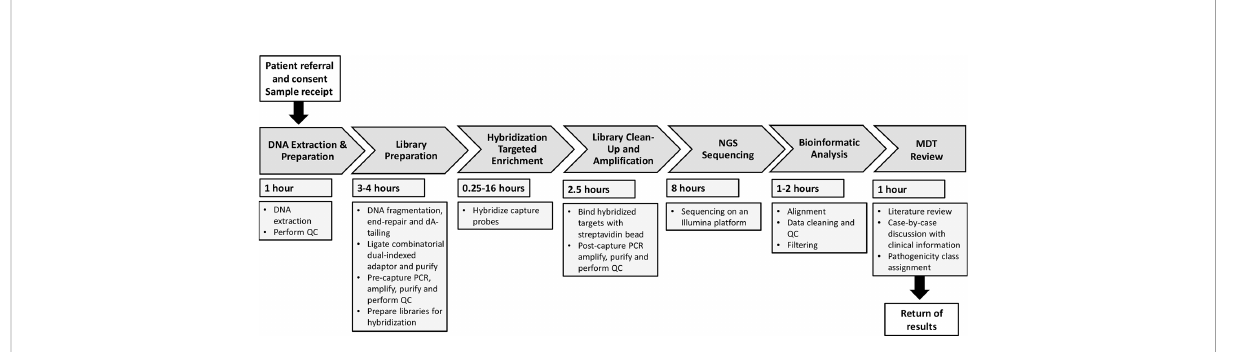
FIGURE 1 Overall work fl ow for the Rapid Autoin fl ammation Panel (RAP). This fl ow diagram represents the seven stages of the RAP work fl ow demonstrating how return of results is achieved <48 hours from receiving a patient sample. QC, quality control; PCR, polymerase chain reaction; NGS, next-generation sequencing; MDT, multidisciplinary